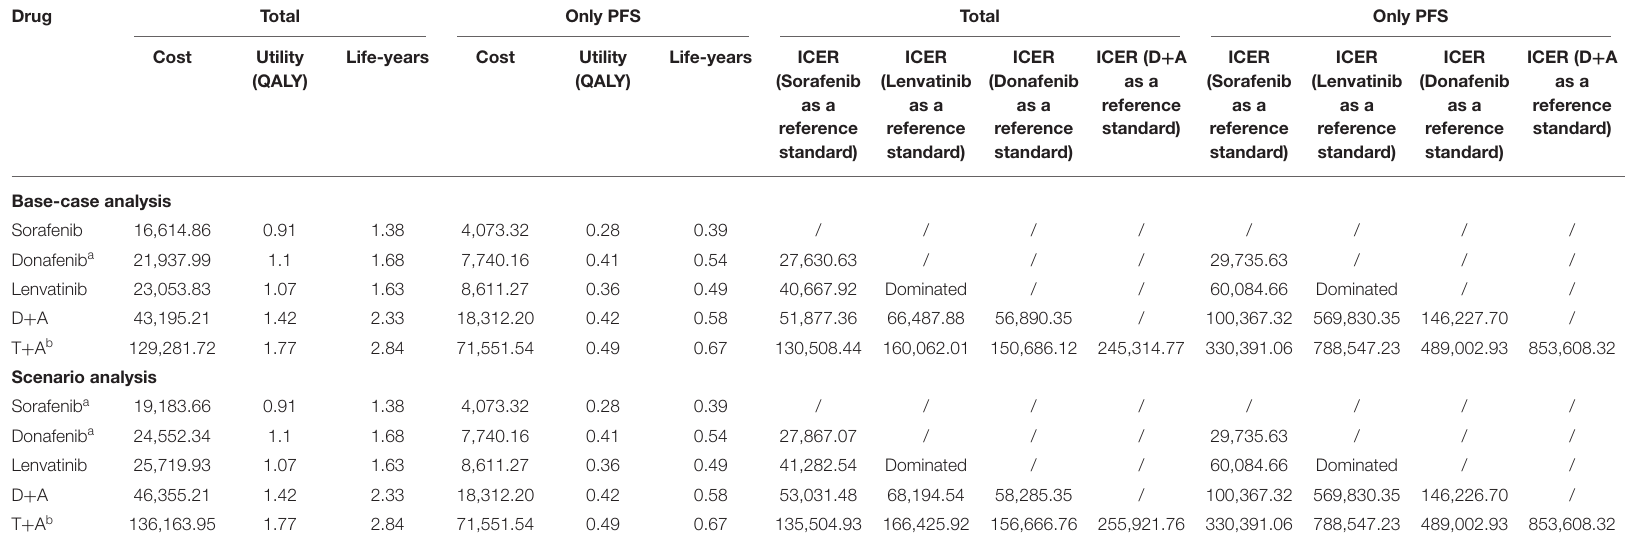
TABLE 2 | Results of base-case analysis and scenario